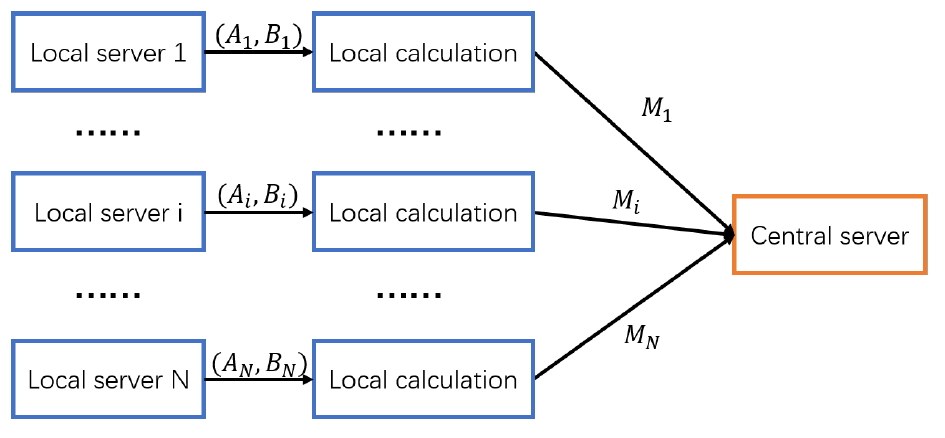
Figure 1. The one-shot communication process of Algorithm 1. Algorithm 2 The power method (PM) in the central